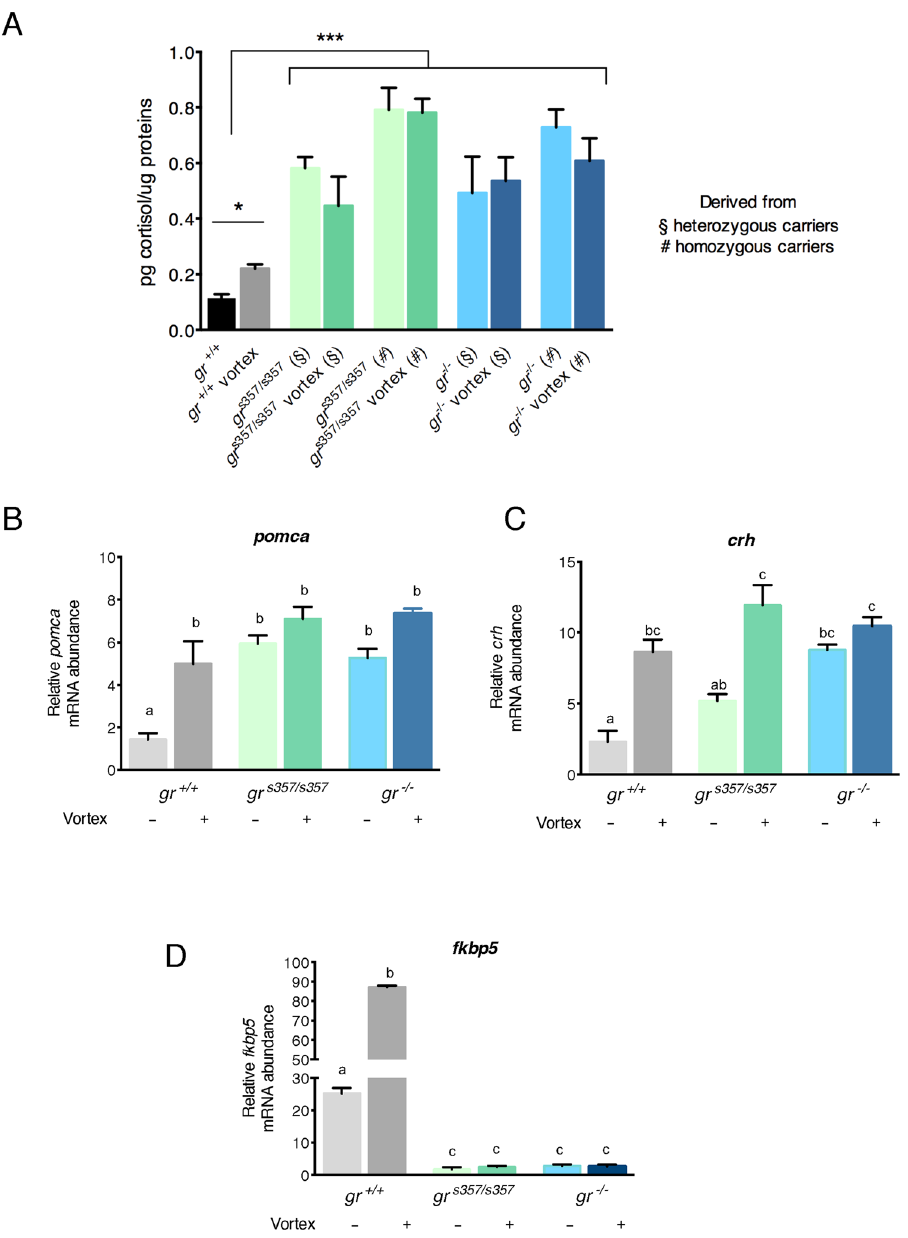
Figure 4. Dysregulation of the HPI axis in the gr mutant lines. ( A ) Whole-body cortisol concentrations as determined by RIA in gr + / + , gr s357 / s357 and gr − / − 5-dpf zebrafish larvae under basal and stressful conditions. Homozygous zebrafish mutants deriving from heterozygous or homozygous parents were analysed separately. Concentrations were determined from 6 pools of 10 larvae (three different experiments) and are expressed as picograms per μ g protein (mean ± SEM). Asterisks indicate that the cortisol concentration is significantly different from the control (two-way-ANOVA, * P < 0.05, *** P < 0.001). ( B ) qRT-PCR analysis of pomca , crh and fkbp5 in gr + / + , gr s357 / s357 and gr − / − 5-dpf zebrafish larvae deriving from homozygous parents under basal and stressful conditions. Values represent the mean ± SEM. Different letters indicate statistically significant differences checked by two-way ANOVA followed by Tukey’s multiple-comparison test. pomca and crh (P < 0.01); fkbp5 (P < 0.001). Data were generated from four biological Analysis of the anti-inflammatory response in gr mutant lines. In order to study the GRE-independent cross-talk of Gr with other pathways, we analysed the response to an inflammatory stimulus in the two gr mutant lines by qRT-PCR expression analysis of genes involved in immune reaction as compared to WT fish. In control 5-dpf larvae of all genotypes, transcription levels of mmp - 13 were very low but, after dextran sodium sulphate (DSS) treatment, they showed up to 40- and 20-fold induction in gr + / + and gr s357 / s357 , respec- tively. No increase was instead observed in the gr − / − line. After DEX treatment, mmp - 13 expression returned to basal level ( gr s357 / s357 ) or was statistically reduced ( gr + / + ) (Fig. 6).